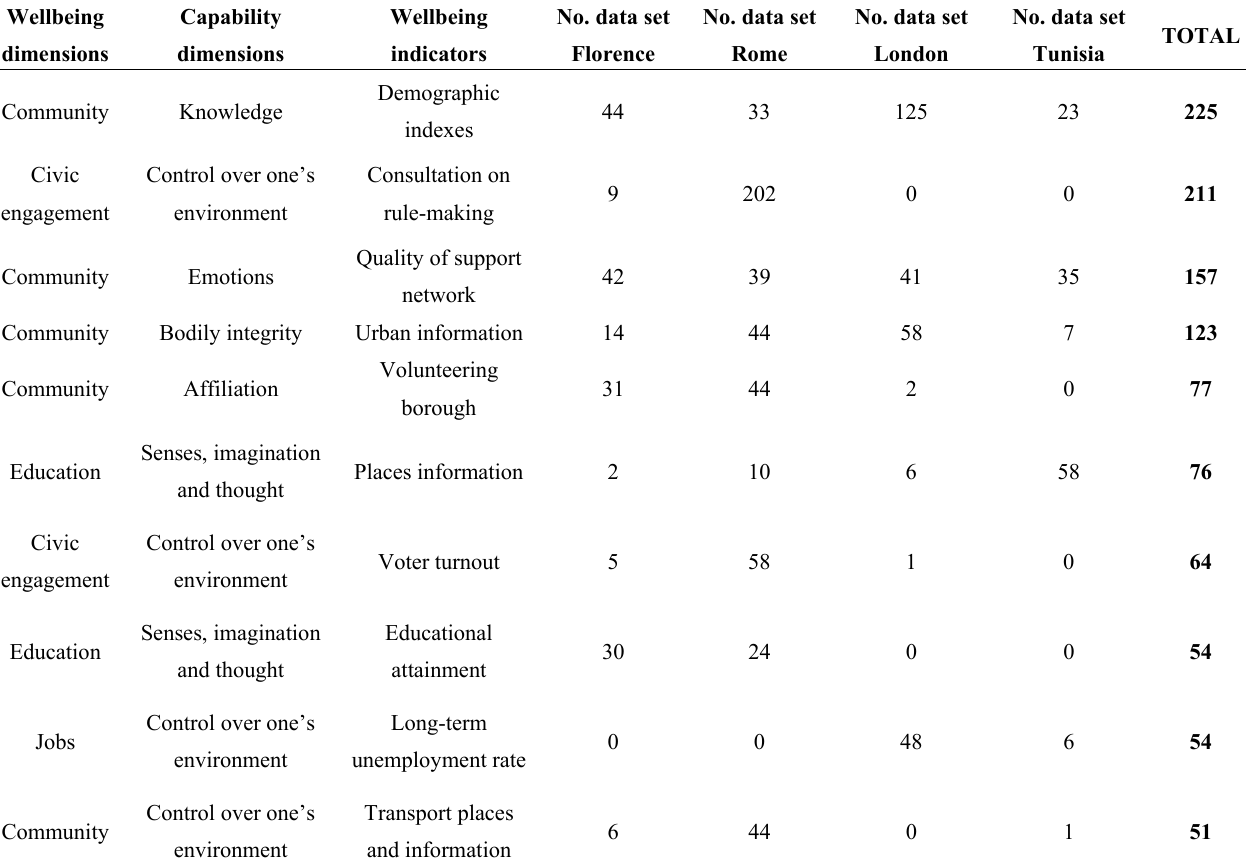
Table 2. Data sets available on each of the considered cases per triple